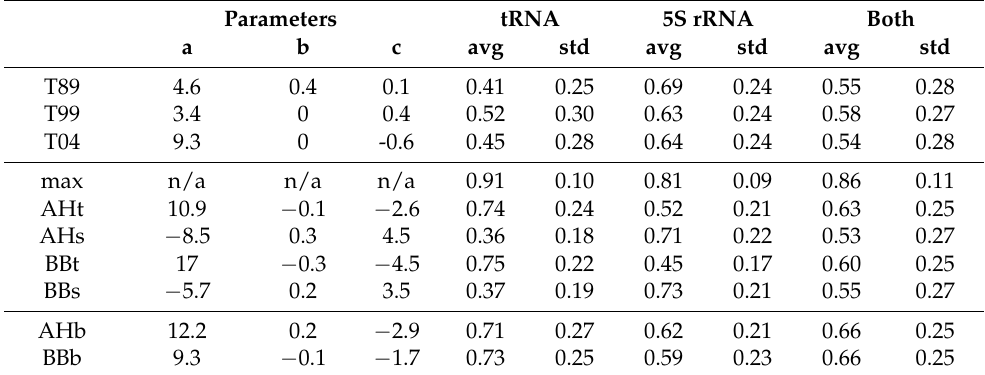
Table 2. Parameter values and MFE prediction for the 50 tRNA training sequences and the 50 5S rRNA, as well as over both